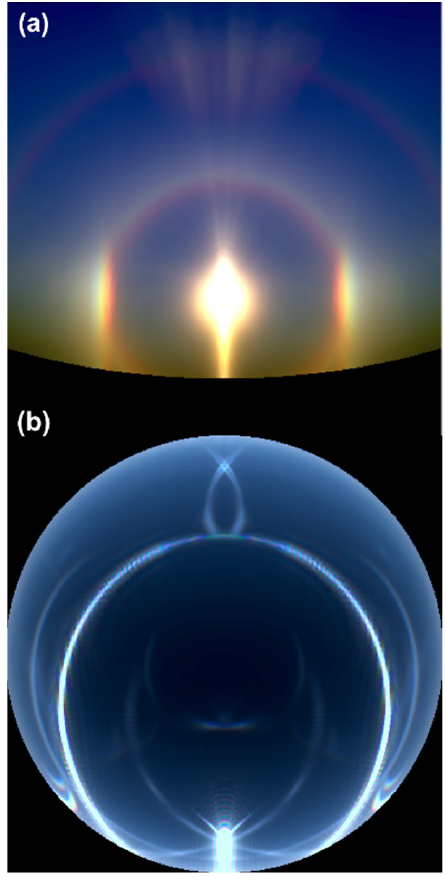
Figure 5. Simulated optical phenomena associated with light scattering by: ( a ) a mixture of horizontally oriented hexagonal ice plates (7.9%) and randomly oriented counterparts (92.1%;) and ( b ) the Parry oriented columns. For the simulated sky image, multiple scattering is not included. See also Liou and Yang [4].